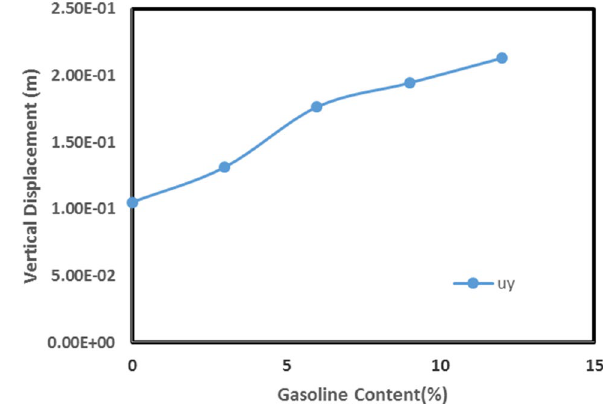
Fig. 23 Settlement changes for soil with different contamination amounts